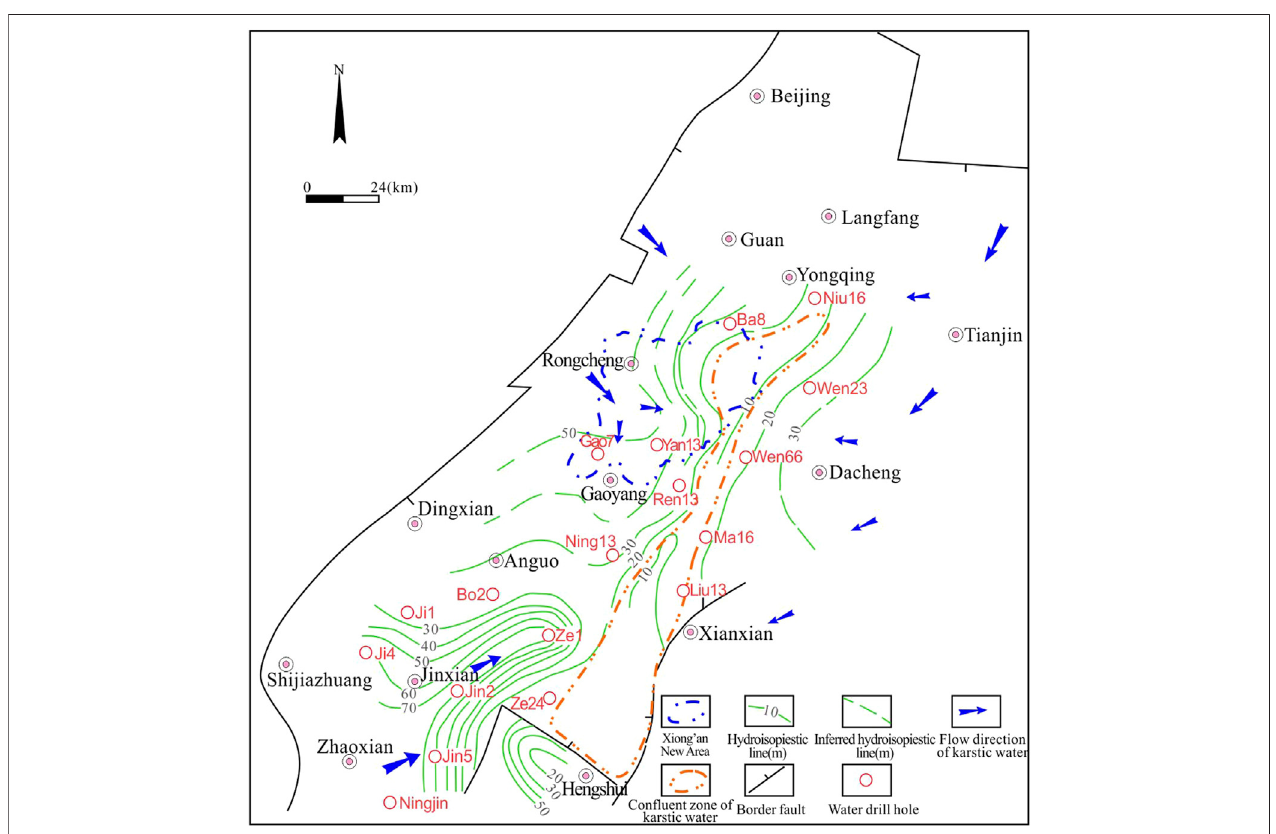
FIGURE 5 | Contour map of piezometric level of buried hill in the Jizhong Depression [according to Yan and Yu (2000)].